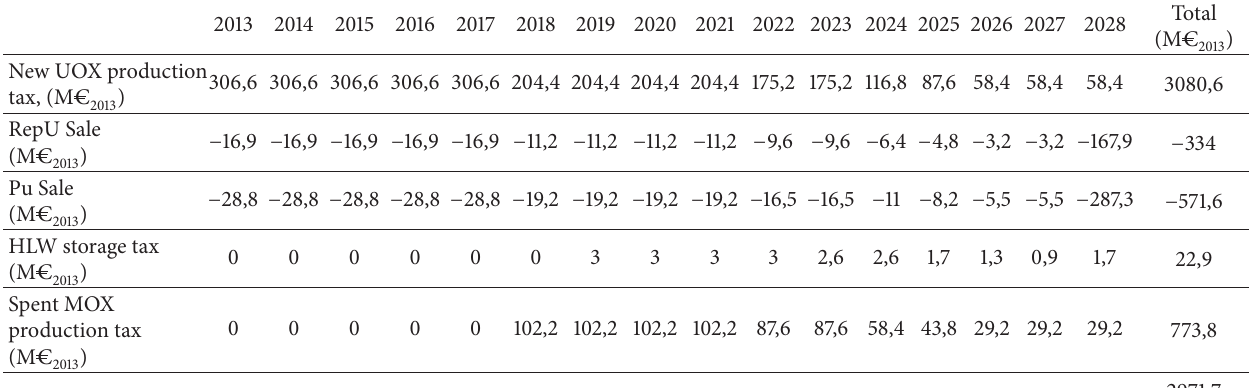
Table 2: Cash flows for the year 2013 by type of tax and year and the total cash flows. Twice-Through Cycle.